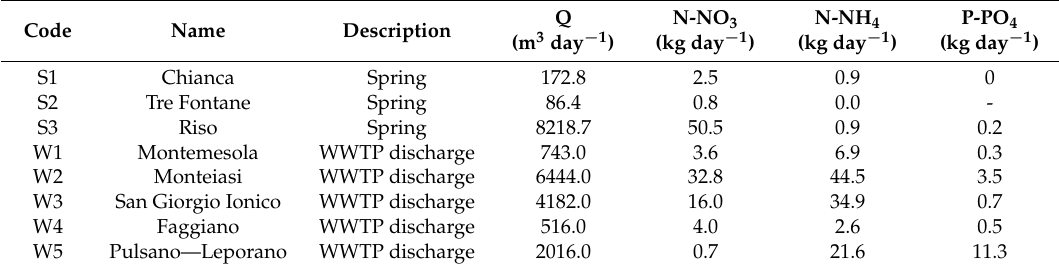
S1, S2, W1, W2, and W3 are located in Basin N; S3, W4, and W5 are located in Basin